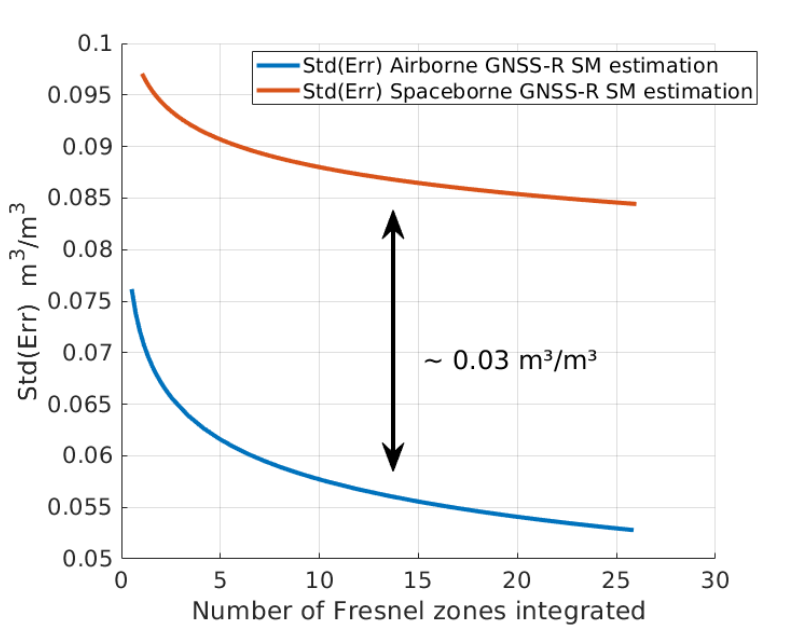
Figure 13. Std(Err) evolution as a function of the number of consecutive Fresnel zones used to derive the SM estimation. Comparison between the airborne case (Microwave Interferometric Reflectometer instrument [62]) and the spaceborne case (FMPL-2). Note that the X-axis is normalized by the number of Fresnel zones used to derive the SM estimation (i.e., the N parameter used in Section 3.3). A regression curve is fit to the Std(Err) of both error curves to ease the